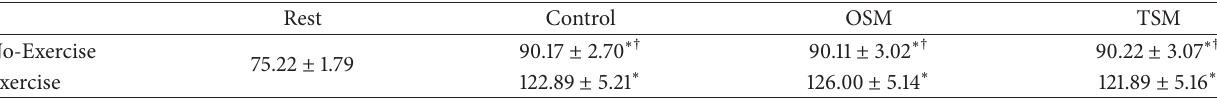
Table 1: Heart rate [bpm].